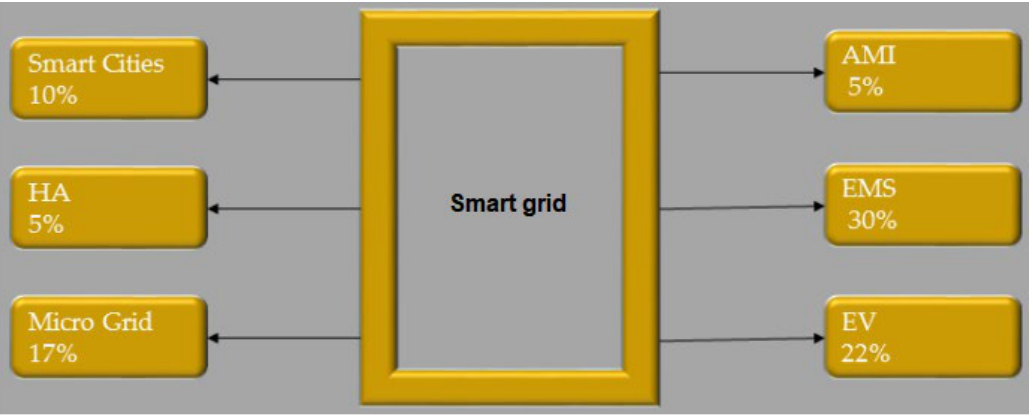
Figure 1. Components of a power grid that houses electrical support systems [2,3].